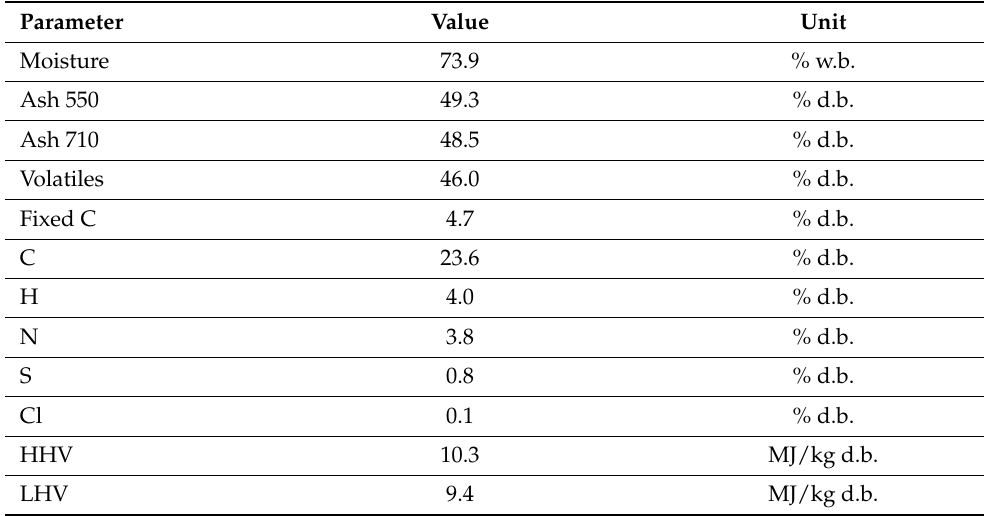
Table 2. Feedstock (sewage sludge) proximate, ultimate, and thermal